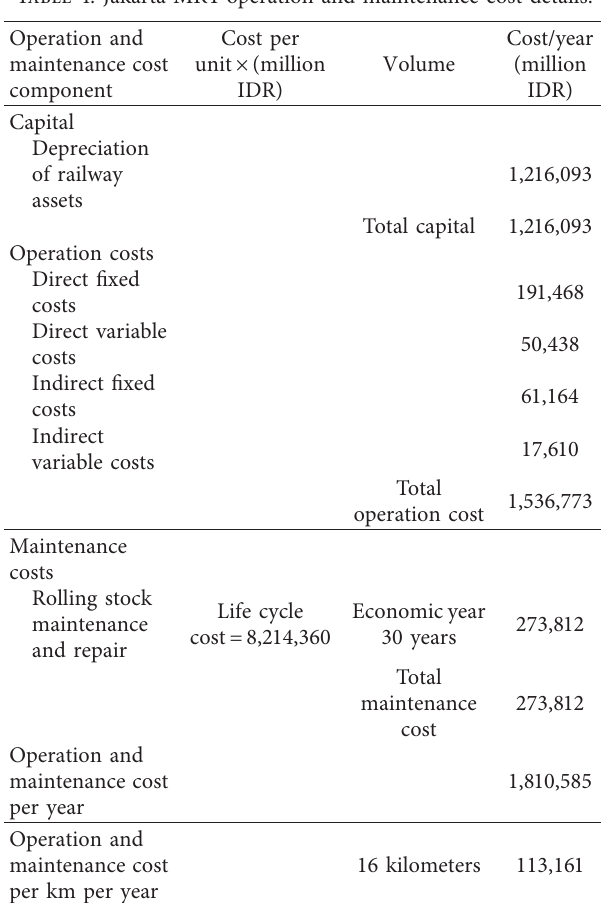
Table 4: Jakarta MRT operation and maintenance cost